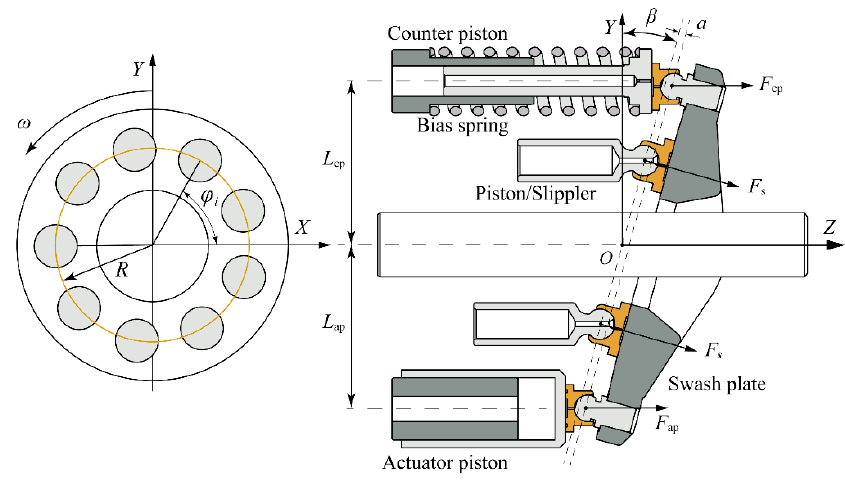
Figure 3. Schematic of swash plate control system.